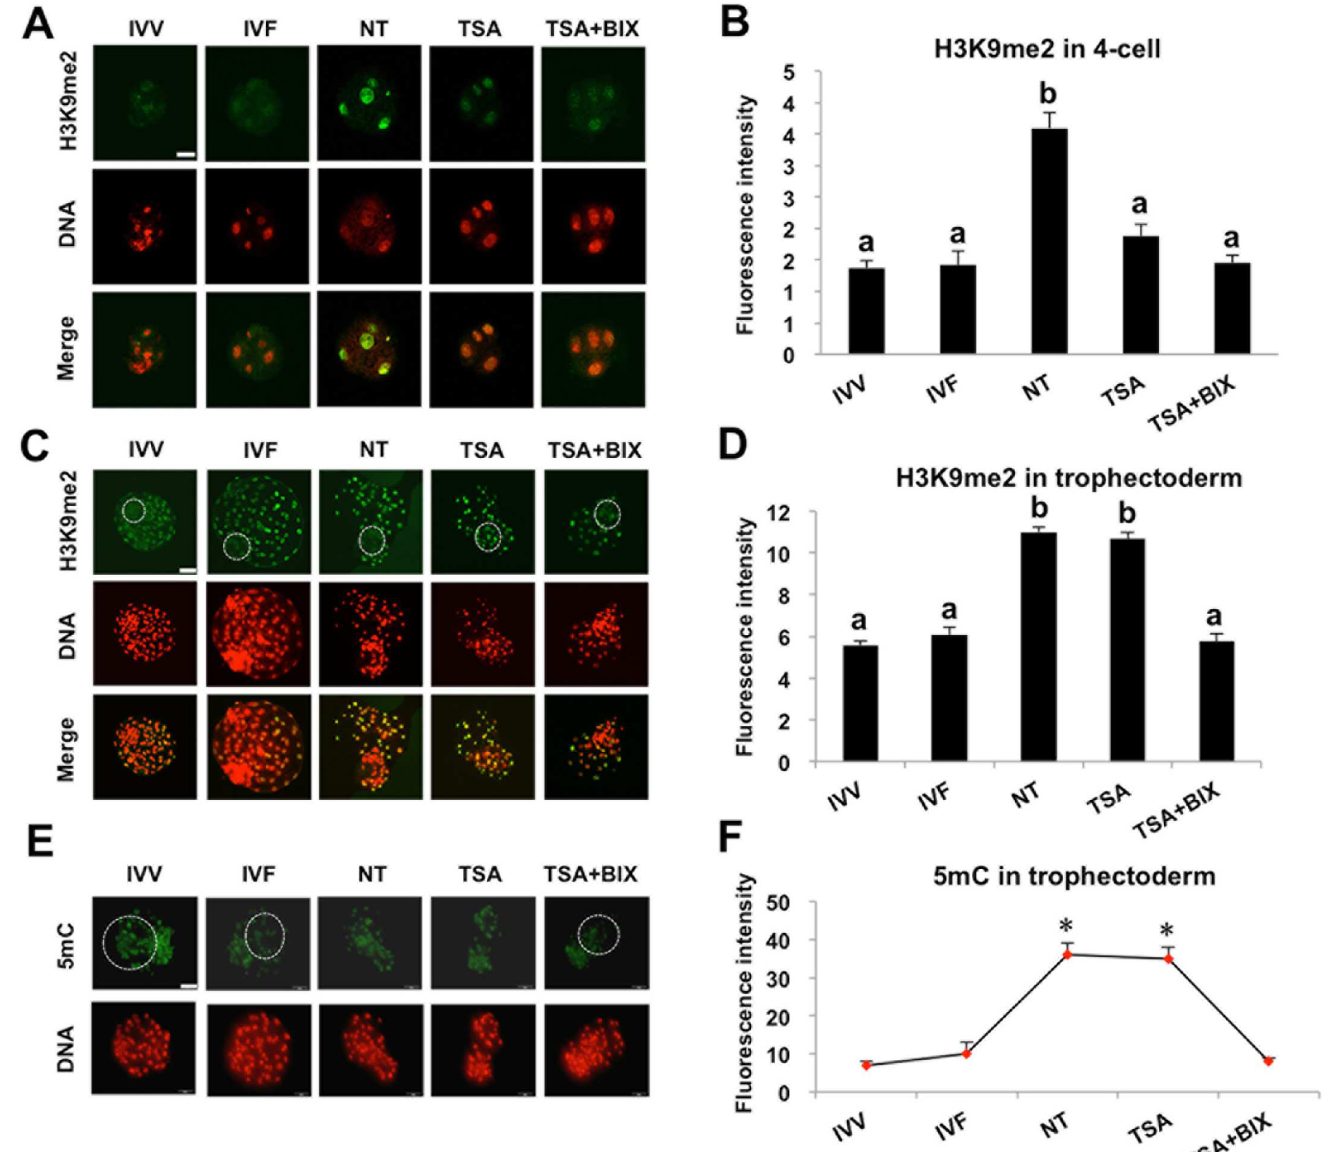
Fig 4. TSA and BIX-01294 treatment combined restores H3K9me2and 5mC levels in SCNT embryos. SCNT embryos at the pronuclearstage were culturedin PZM-3 supplemented with 50 nM TSA or 50 nM TSA and 1 μ M BIX-01294for 24 h and SCNT embryos culturedin PZM-3 containing DMSO were served as NT control. Then DMSO, TSA and BIX-01294in different groups were washedout and embryos were cultured in fresh PZM-3 medium until day7. We isolated and fixed the 4-cell and blastocysts from different groupsincludingNT control, TSA treatment, TSA and BIX-01294 combination treatment for subsequent experiments. At the same time, in vivo fertilized (IVV) and in vitro fertilized (IVF) 4-cell and blastocysts were also collectedand fixed. Finally, 4-cell embryos (A) and blastocysts (C) were stainedfor H3K9me2(green)and DNA (propidiumiodide, red). Bottom panels showedthe merged images (yellow)betweenH3K9me2signals(green) and DNA staining(red). (E) Blastocysts from all groups were stainedfor 5mC (green) and DNA (propidiumiodide, red). Shown in A, C and E are representative Z-sections obtainedby confocalmicroscopy from one experiment. White dash circle denotesICM area in C and TE regionin E , respectively.Scale bars = 50 μ m. (B, D) Quantification of the H3K9me2fluorescence intensity in nucleus of 4-cell and trophectoderm cells. (F) Quantification of the 5mC fluorescence intensity in nucleusof trophectodermcells. Data in B, D and F are shown as mean ± S.E.M. All experiments abovewere repeatedthree times with 20 embryos per group. Valueswith different superscripts across groups indicatesignificantdifferences ( P < 0.05) and * P <